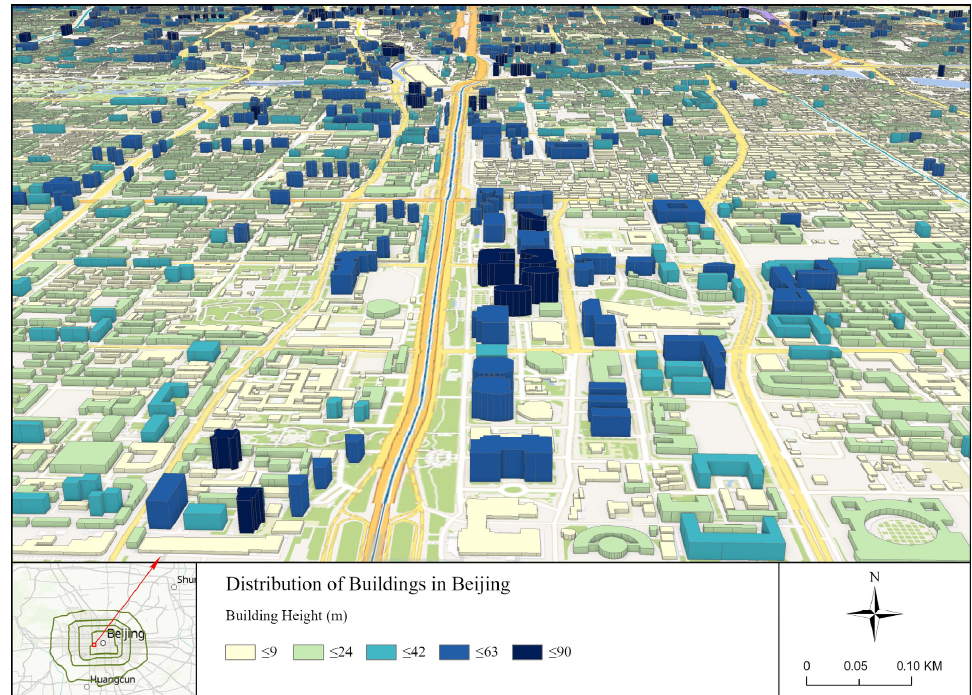
Figure 4. Example of building distribution in Beijing (the enlarged image shows Xi Dan).